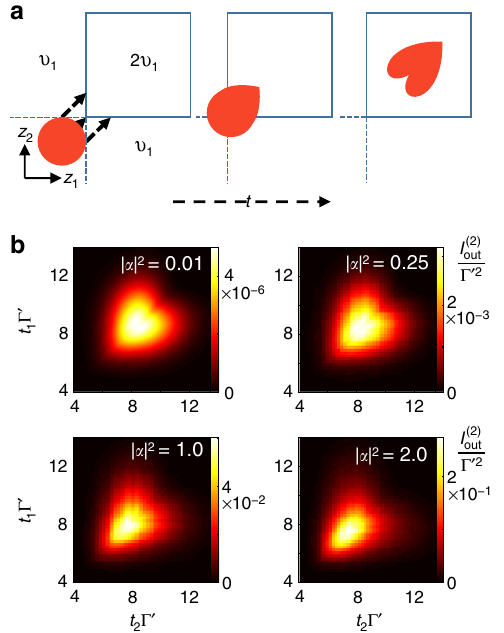
Fig. 6 VIT pulse distortion. a Distortion process as a two-photon wave- function ψ ( z 1 , z 2 ) enters the atomic medium. The initial Gaussian distribution of the photon positions z 1 and z 2 is shown as a circle. The two- dimensional space of the photon pair is divided into regions where only one photon is inside the medium and has group velocity v 1 , indicated by the dashed lines, and when both photons are inside the medium having velocity v 2 = 2 v 1 , the square box. Photon pairs with greater separation spend more time in the regions where only one photon is inside the medium, delaying them compared to pairs with z 1 = z 2 , leading to a characteristic heart shaped pattern. b Two-time correlation function I ð 2 Þ t 1 ; t 2 ð Þ for the output out fi eld of the VIT system, after excitation with a coherent Gaussian input pulse for various average input photon number: | α | 2 = 0.01, 0.25, 1.0, and 2.0. At weak input fi eld the correlation function is purely due to the two photon component and shows a clean heart shape. As the number of input photons increases, higher photon number components contribute, which travel faster through the medium distorting the pattern and pulling it forward in time. The system parameters were for an optical depth of OD = 60, with N = 30, Γ 1 D = Γ ′ , Δ = δ c = 0, g = 4, Γ ′ , κ = 0.03 Γ ′ , σ t = 4/ Γ ′ and t 0 = 6/ Γ ′ . We used bond dimension D = 30 and time step δ t = 0.01/ Γ ′